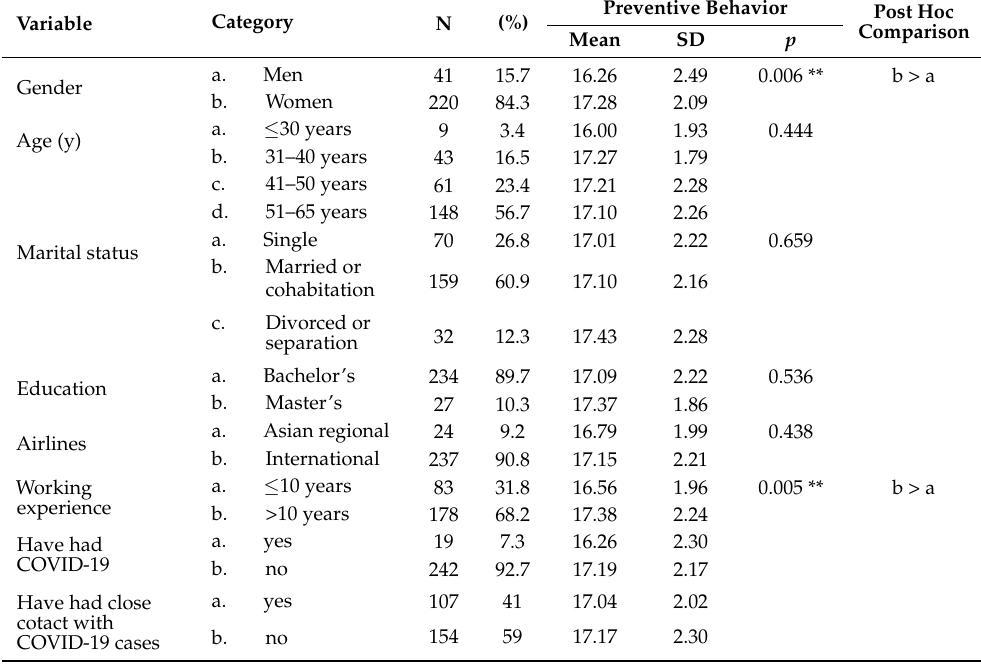
Table 1. Participants’ sociodemographic characteristics ( n = 261). ** p <